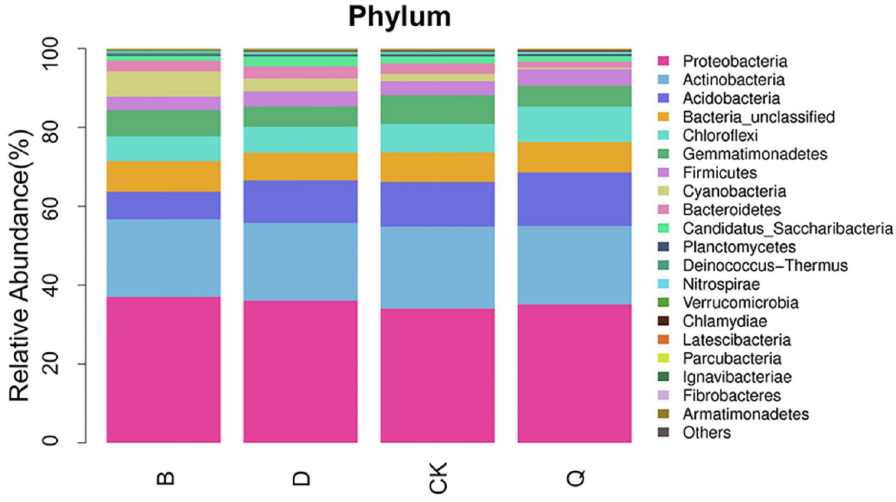
Fig 2. Relative abundance of main bacterial genera (top 20) in continuous tomato cropping substrates under different cropping systems. CK: Continuous tomato cropping; B: Cabbage/tomato rotation; D: Kidney bean/tomato rotation; Q: Celery/tomato